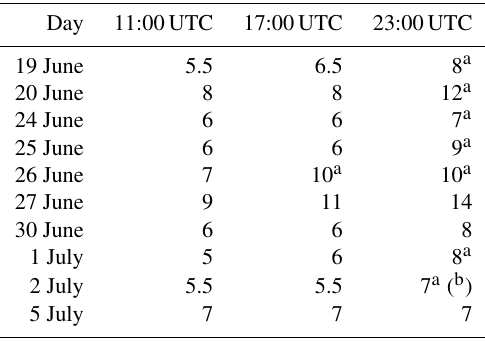
Table A1. Near-surface specific humidity from standard ra- diosoundings [gkg − 1